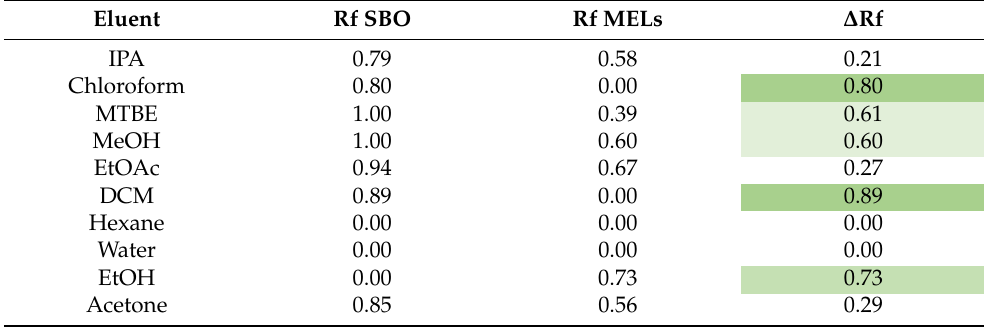
Table 2. Rf values of MELs and SBO for different organic solvents. Solvents with ∆ Rf higher than 0.50 and higher than 0.75 are highlighted in green and dark green, respectively, indicating potential higher and superior separation between MELs and